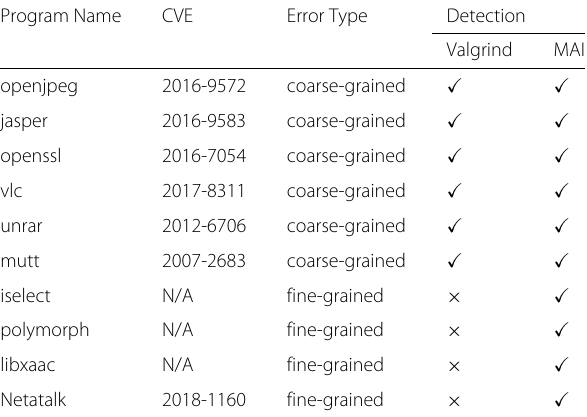
Table 4 The comparison detection result on 10 real